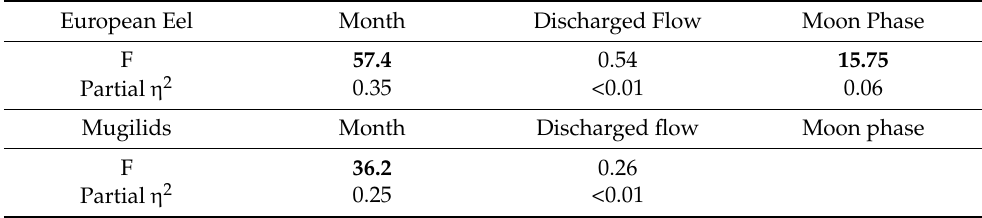
Table 5. Main results of the general linear models relating the ind.cyle − 1 according to the explanatory variables accounting at least for 5% of the variance. Significant factors ( p < 0.05) are denoted in bold. Adjusted r-squared were 0.54 and 0.31, respectively, for eel and mugilids.